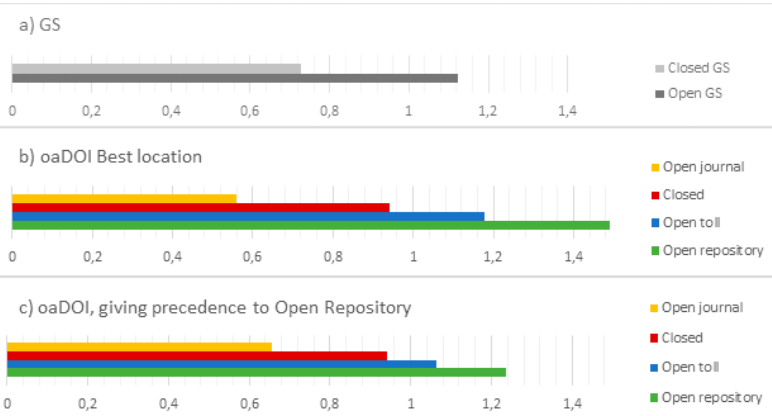
Figure 4. Mean relative citation frequencies of articles indexed in ( a ) Google Scholar, ( b ) oaDOI Best_location (here Open Repository refers to self-archived-only), and ( c ) oaDOI giving precedence to Open Repository, i.e., all self-archived articles. The analysis was based on articles published between 2011 and 2015.